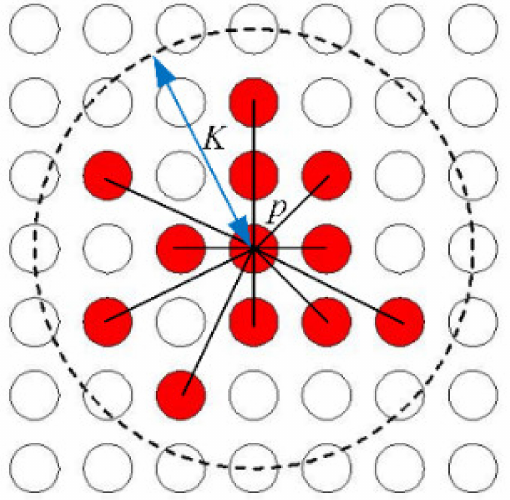
Figure 3. The density schematic diagram of the point p